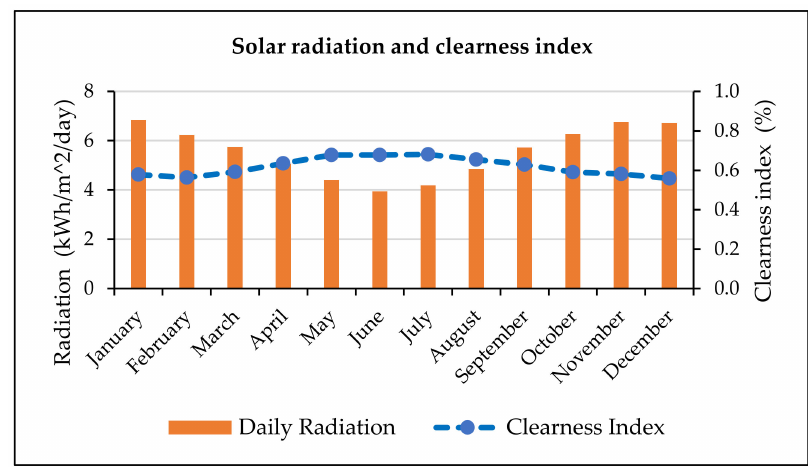
Figure 2. Solar radiation and clearness index. Courtesy of HOMER [39].